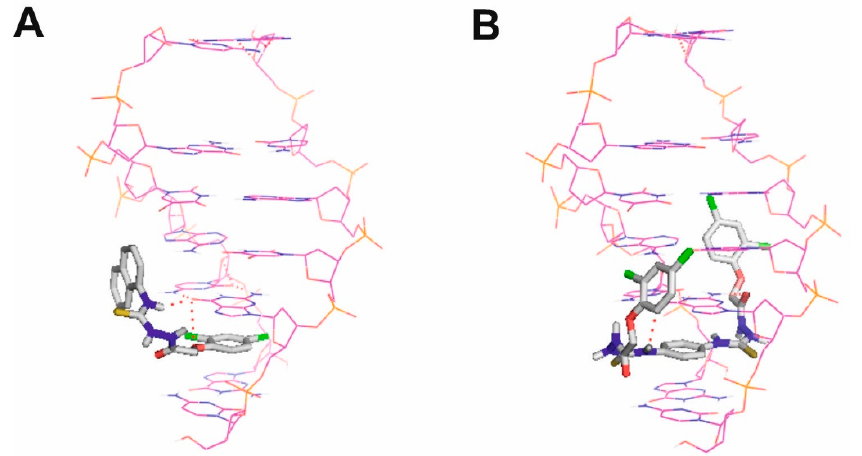
Figure 11. Absorption spectra of calf thymus DNA (250 µg/mL) in phosphate buffer (pH 7.4) upon addition of compound 2 (10, 20, 30, 40, and 50 µM, respectively).